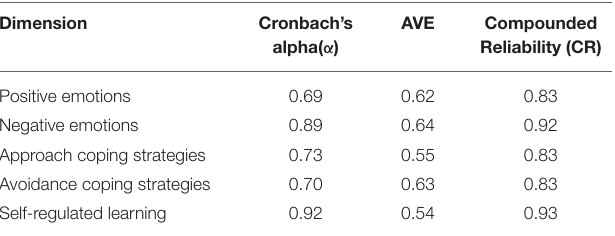
TABLE 5 | Measurement model